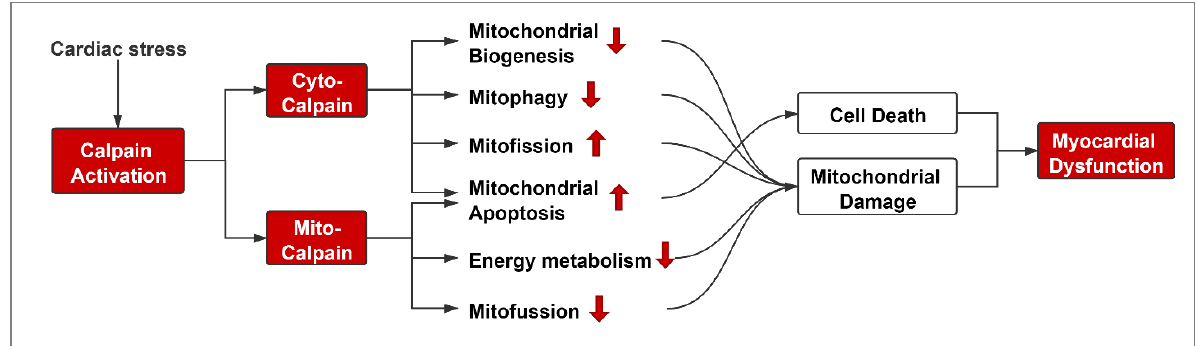
Figure 3. Calpain-mediated mitochondrial injury contributes to cardiac diseases. Under pathological conditions, cardiac stress leads to overactivation of calpain, including cyto-calpain and mito-calpain. Cyto-calpain contributes to impairment of mitochondrial biogenesis and mitophagy, promotes mitofission and mitochondrial apoptotic pathway. Mito-calpain dampens mitofussion and mitochondrial energy metabolism and facilitates mitochondrial apoptosis. Thus, cyto-calpain and mito-calpain work separately yet synergistically in mediating mitochondrial damage and cell death, leading to myocardial dysfunction and eventually contributing to the progression of heart